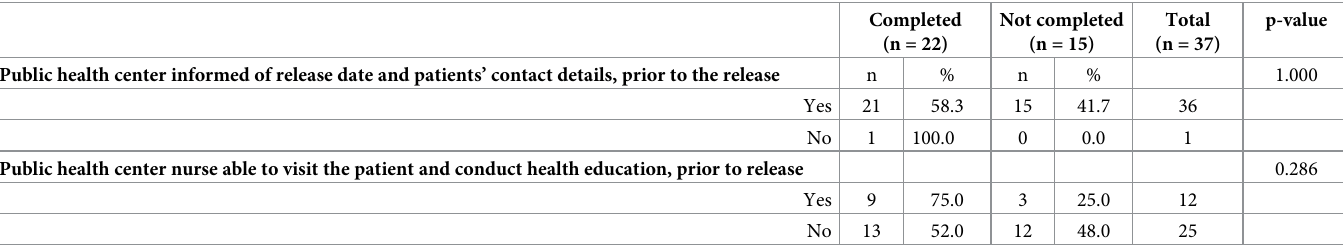
Table 5. Treatment outcome of those who were released while still on LTBI treatment, 2015–2016 (n =